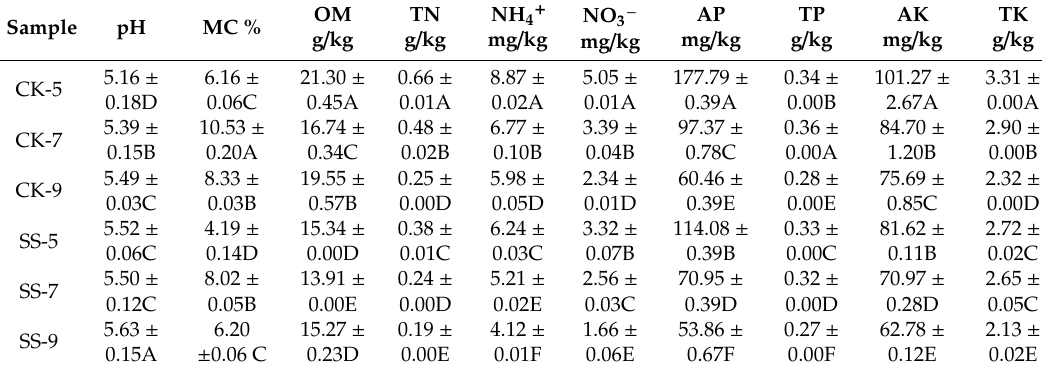
Table 1. Comparative analysis of soil physicochemical properties of CK-5, CK-7, CK-9,SS-5, SS-7, SS-9. CK: Control, soil of non-infected P. sylvestris var. mongolica ; SS: treatment, soil of infected P. sylvestris var. mongolica ; May, July, and September represent spring, summer, and autumn,